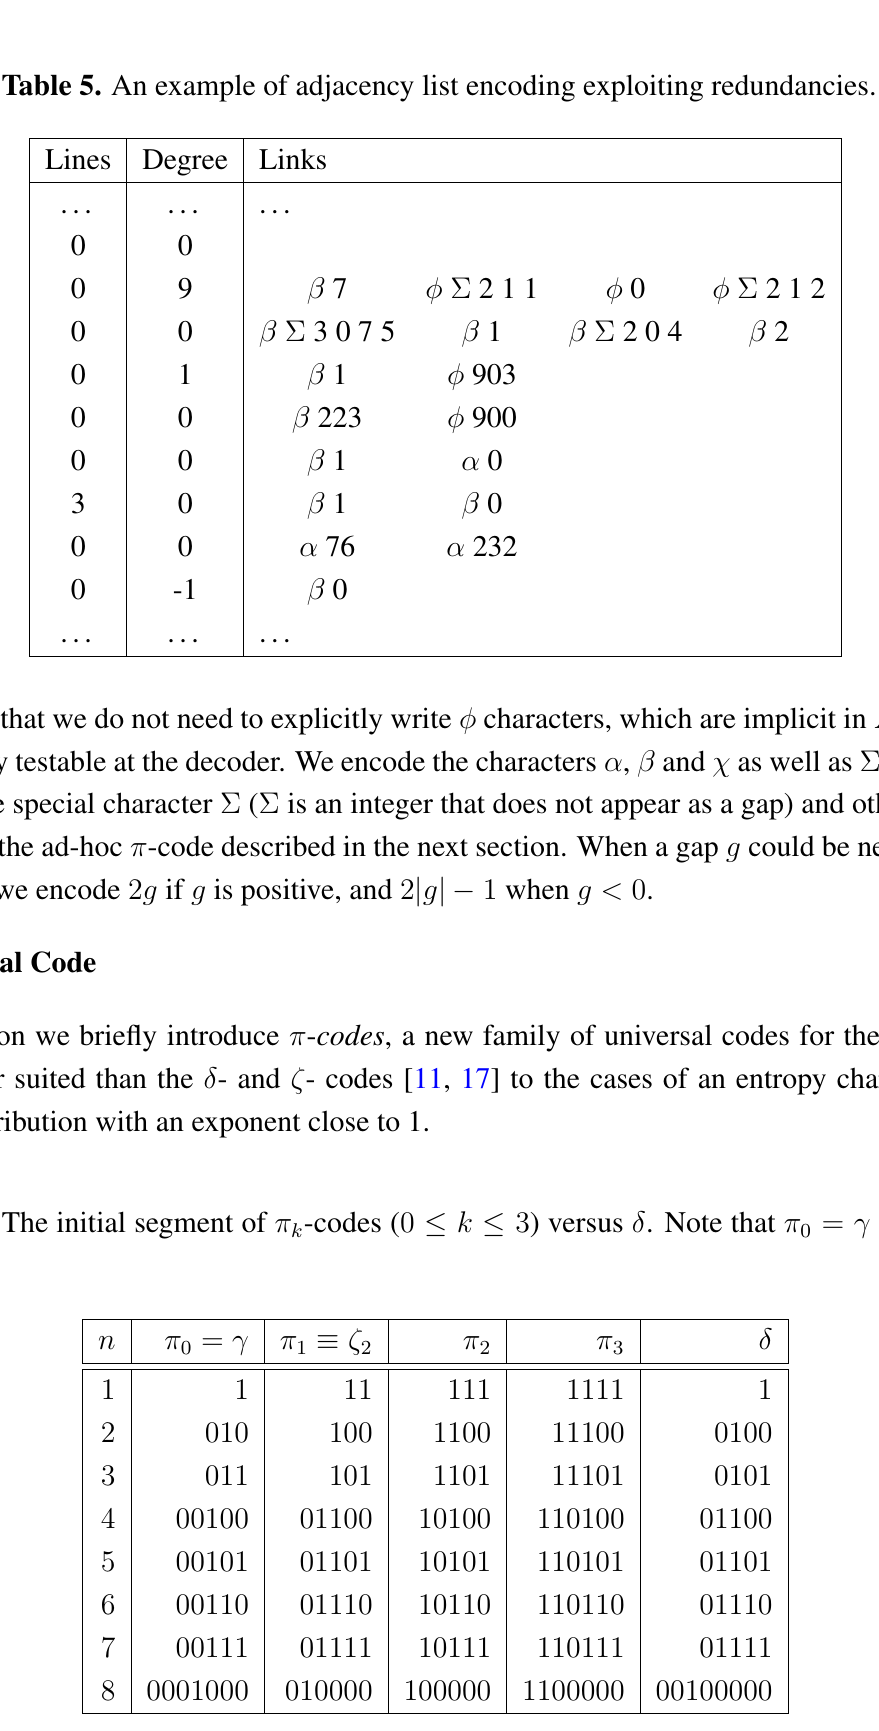
-codes ( 0 ≤ k ≤ 3 ) versus δ . Note that π k